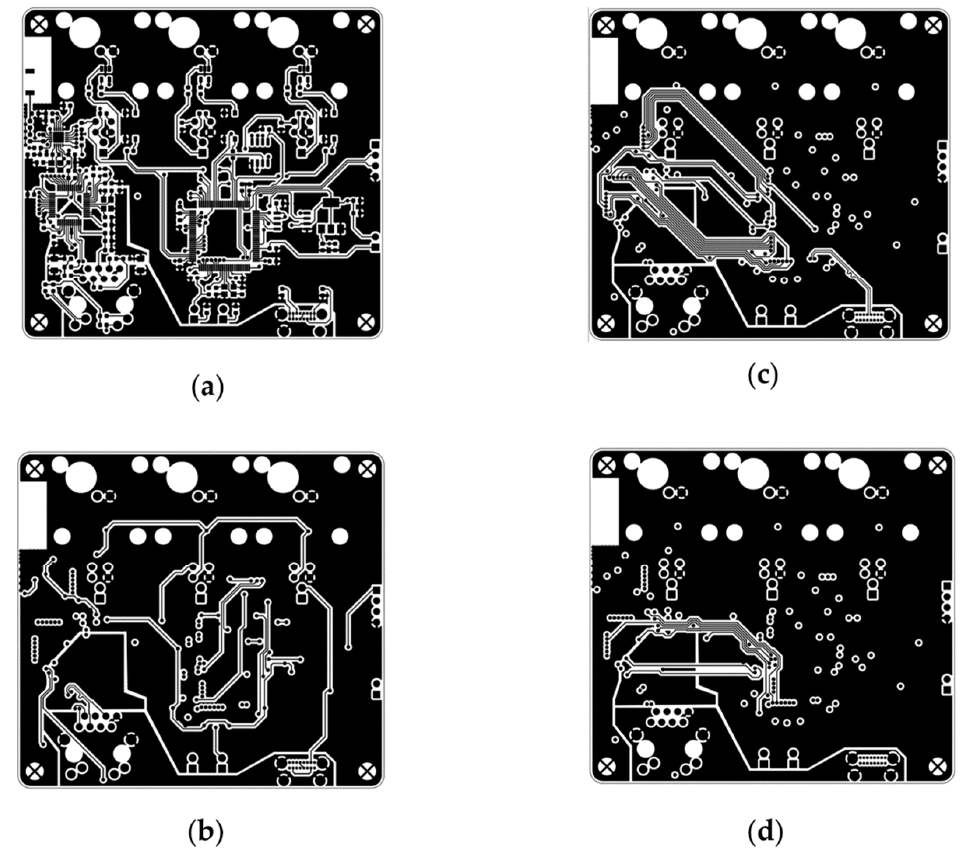
Figure A7. Base station PCBs: ( a ) Layer B_Cu, ( b ) Layer Top_Cu, ( c ) Layer In1_Cu, ( d ) Layer In2_Cu.